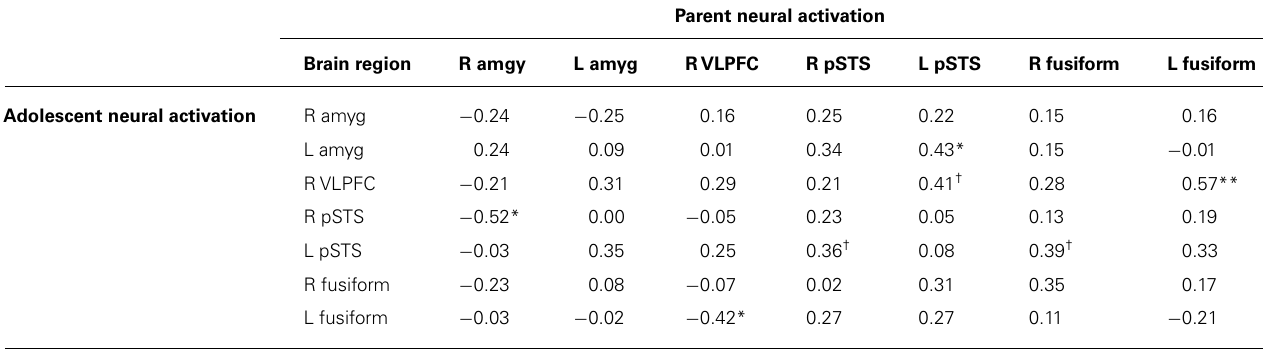
Table 2 | Correlations between adolescent and parent neural responses during affect labeling versus shapes matching.